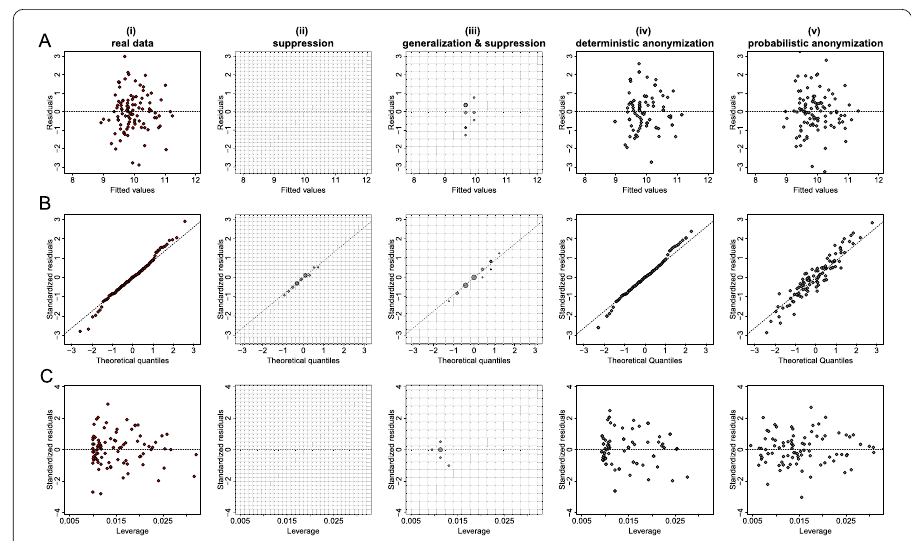
Figure 19 The performance of the techniques applied in a sample of 100 observations. From top to bottom we demonstrate the residuals vs fitted values plots ( A ), normal QQ plots ( B ), and standardized residuals vs leverage plots ( C ) for real regression outcomes (i), suppressed regression outcomes (ii), generalized and suppressed regression outcomes (iii), deterministically anonymized regression outcomes (iv) and probabilistic anonymized regression outcomes